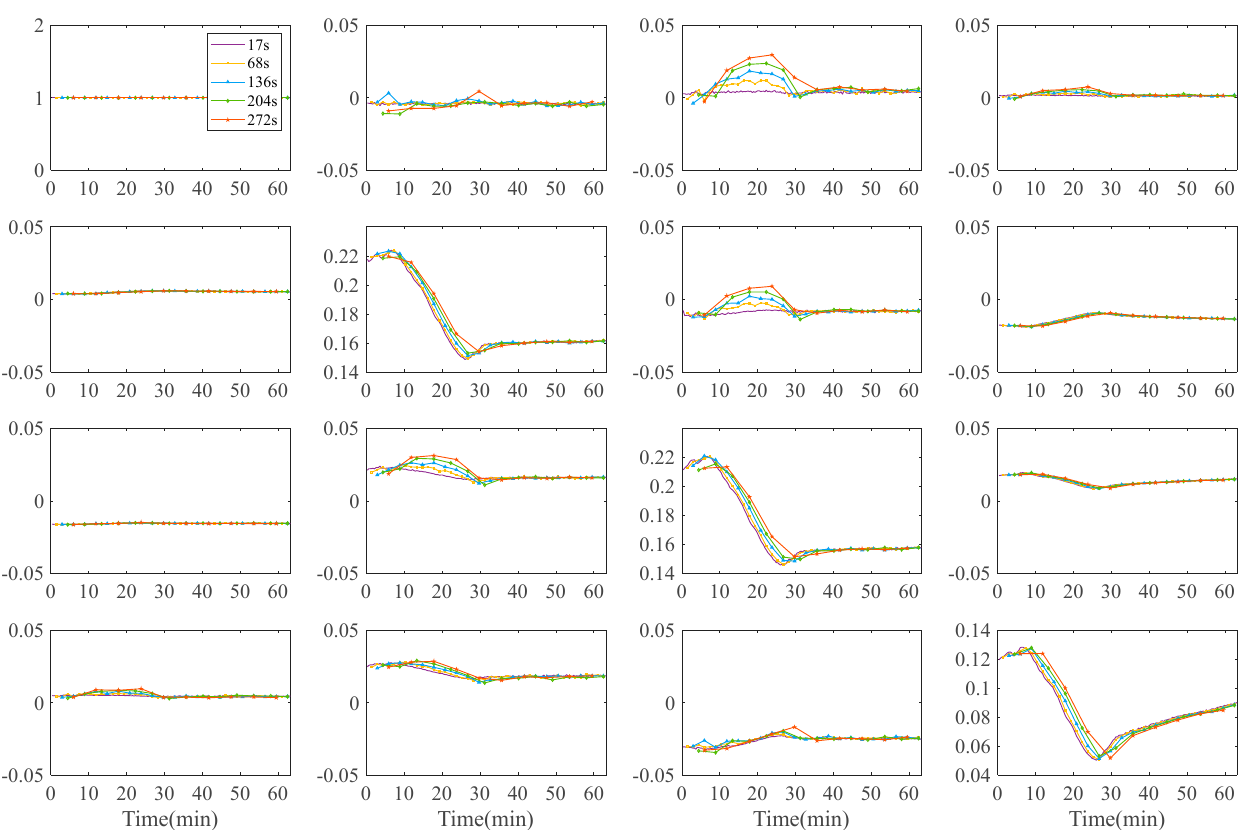
Figure 4. Average value of the MM elements for double-layer tissue at different times of single measurement: 17 s (the purple line), 68 s (the yellow line), 136 s (the blue line), 204 s (the green line) and 272 s (the red line). The horizontal axis represents the time after application of 10% glycerin to the double-layer tissue.